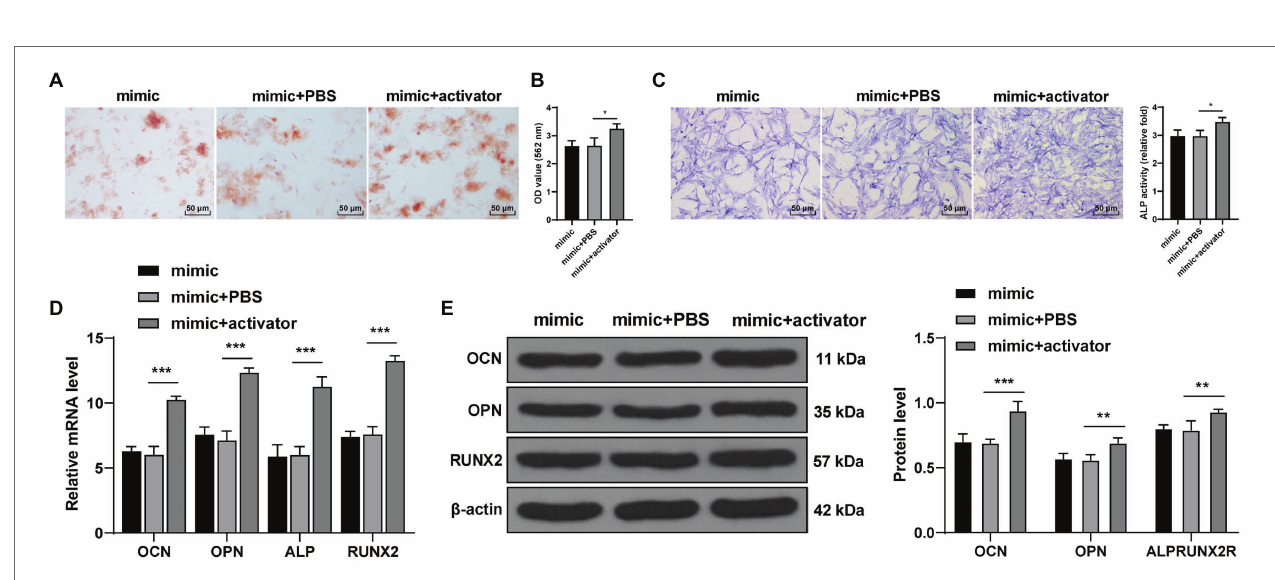
FIGURE 5 | miR-143-3p targeted KLF5 and inhibited the Wnt/ β -catenin pathway in hPDLCs. (A,B) After intervention of miR-143-3p and KLF5, protein levels of Wnt7b and β -catenin during osteogenic differentiation of hPDLCs were detected using RT-qPCR and Western blotting. The experiment was repeated three times. Data are expressed as mean ± standard deviation. Two-way ANOVA was applied to assess data in panels (A,B) , followed by Tukey’s multiple comparisons test, ** p < 0.01, *** p < 0.001.